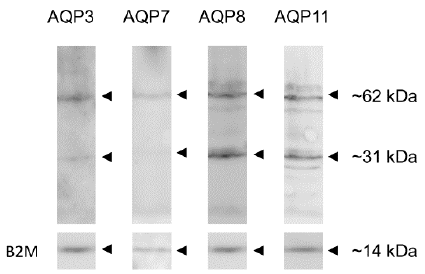
Figure 1. Aquaporin-3 (AQP3), -7 (AQP7), -8 (AQP8) and -11 (AQP11) protein expression in human ejaculated semen from normospermic subjects. Blots representative of three were shown. Lanes were loaded with 40 μ g of proteins, probed with anti-AQP3, -7, -8 and -11 rabbit polyclonal antibodies and processed as described in Materials and Methods. The same blots were stripped and re-probed with anti-beta-2-microglobulin (B2M) polyclonal antibody, as housekeeping. Major bands of about 31 kDa (monomer) and 62 kDa (dimer) were observed.